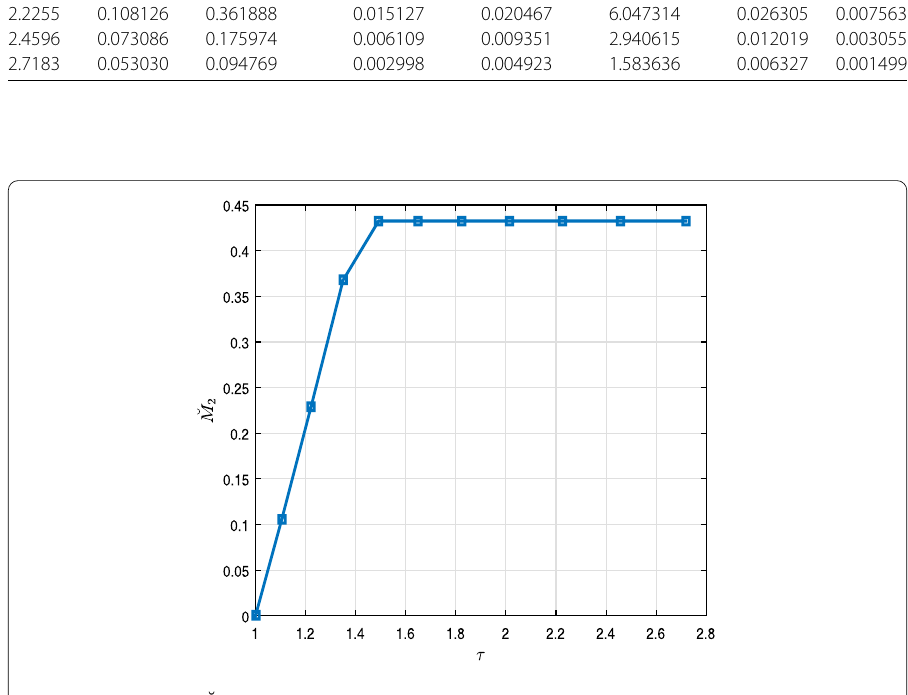
Figure 4 2D-graph of ˘ M 2 for τ ∈ [1, e ] in Example 6.2